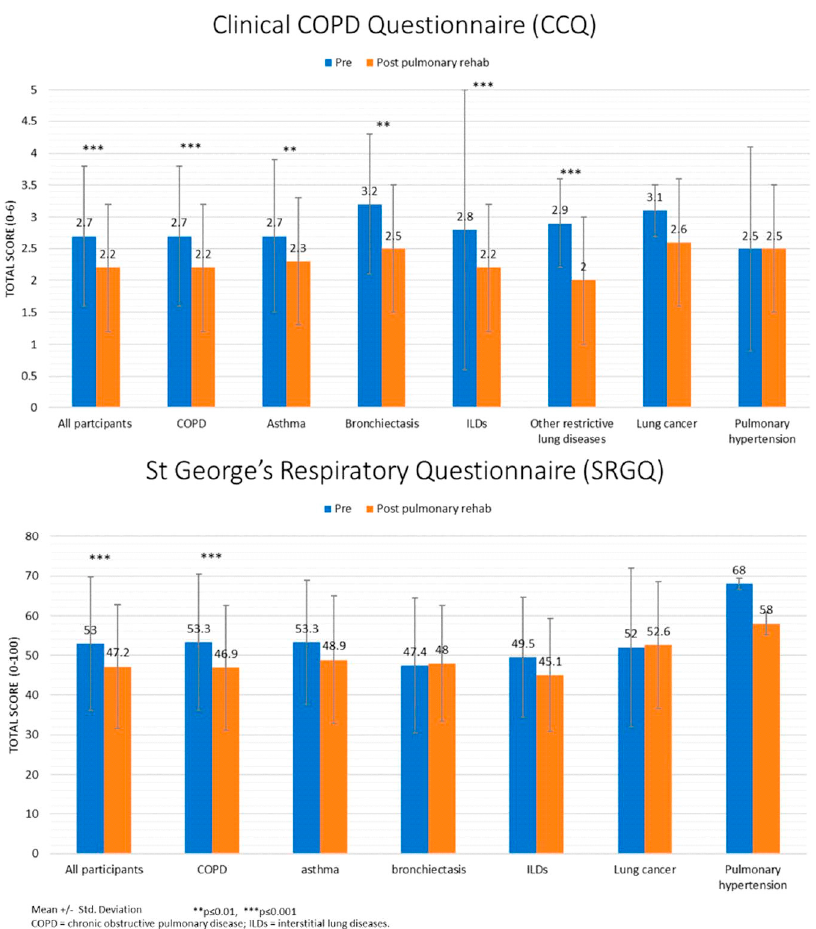
Figure 3. Health-related quality of life pre-post Pulmonary Rehabilitation program.